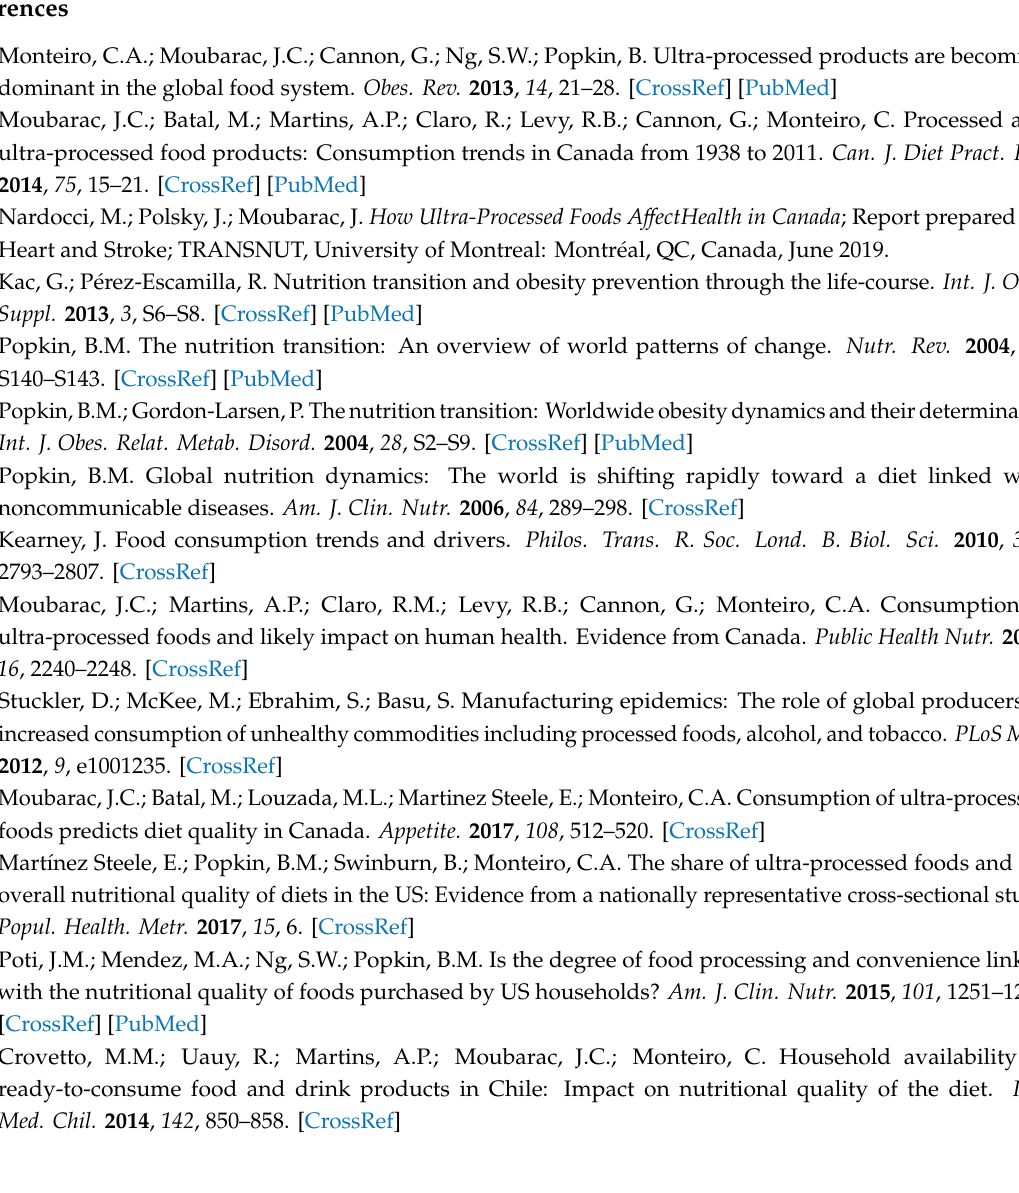
Table S1: Definitions and example foods for each category of the NOVA and Poti et al. food processing classification